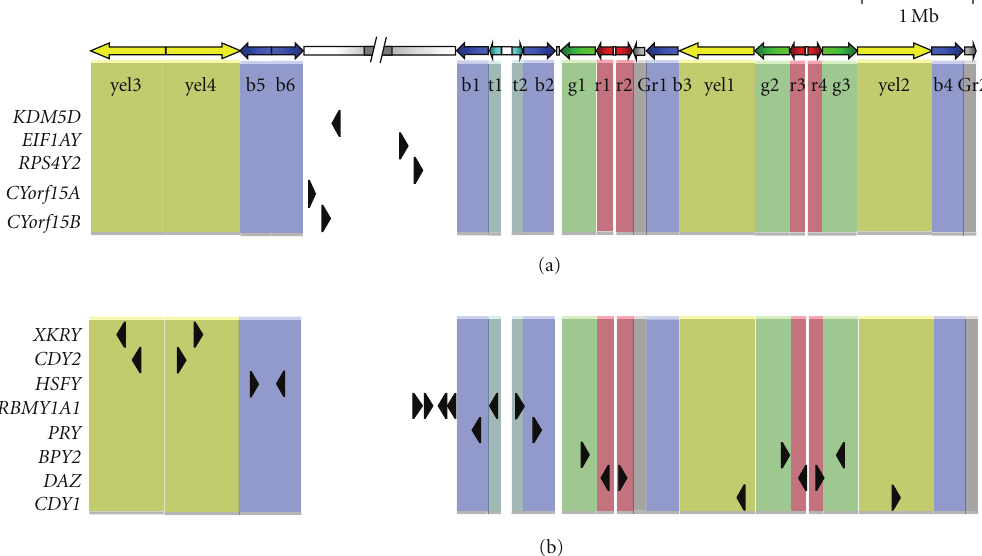
Figure 3: Mapping and sequence organization of the transcription units located in the reference AZFb and AZFc regions of the human Y chromosome. Top schematics represent the genomic organization of the AZFb and AZFc regions, as defined by Kuroda-Kawaguchi et al., [65] and Repping et al., [20]. Block arrows represent amplicon units and rectangles single-copy domains. The DYZ19 heterochromatic region is identified by a discontinuous grey rectangle. a- Single-copy transcription units. Direction of the triangles indicates the 5 (cid:3) -3 (cid:3) orientation of the reading frames. All these sequences map outside of the ampliconic regions. b- Multi-copy sequence families. Number of triangles per line indicates active copy number inside each sequence family. These range from two ( XKRY , CDY1 , CDY2 , HSFY , and PRY ) to six ( RBMY1A1 ). All multi-copy transcription units bar four members of the RBMY1A1 family map to ampliconic domains. Pseudogenes are not